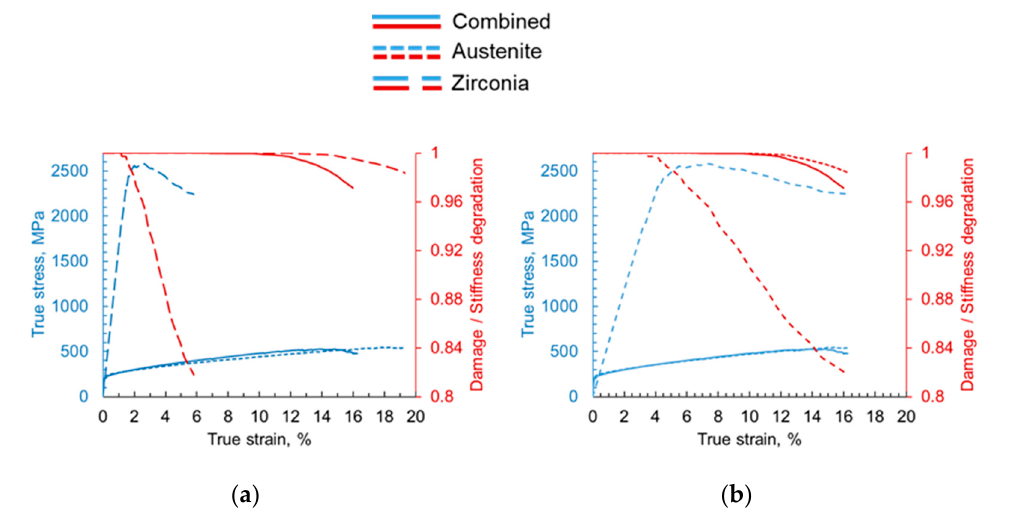
Figure 2. Averaged true stress (blue) and stiffness degradation (red) versus true strain for the zirconia (dashed line), austenite (dotted line), and composite (solid line). True values of stress evolution for each phase with respect to true strain in each phase are presented in ( a ), whereas, True stress values for each phase with respect to normalized strain in the composite are presented in ( b ).